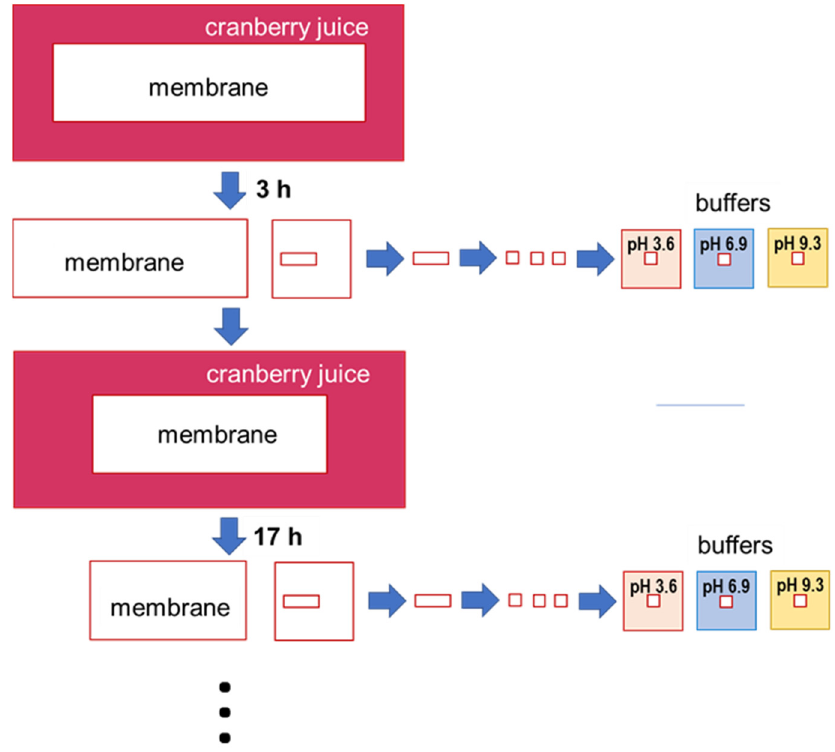
Figure 2. Coupon preparation for optical visualization of membrane fouling with cranberry juice.